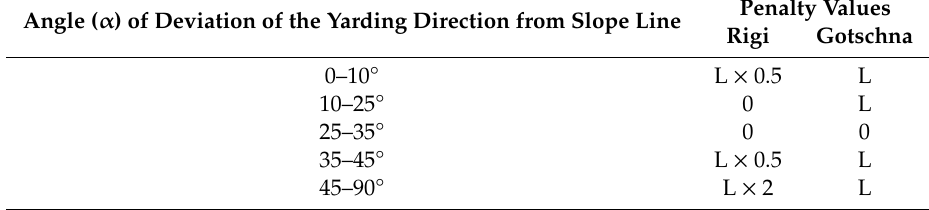
Table 2. Penalty value for the angle of deviation of the cable roads (CR) direction from the slope line. (L: length of the CR within the corresponding angle of